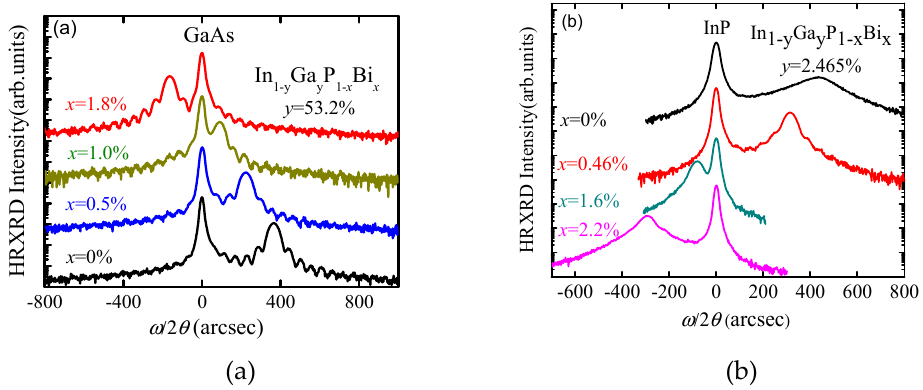
Figure 12. XRD rocking curves of InGaPBi films grown on ( a ) GaAs, Reproduced from Reference [162], Copyright 2015 by the Japan Society of Applied Physics; and ( b ) InP, Reproduced from Reference [117].